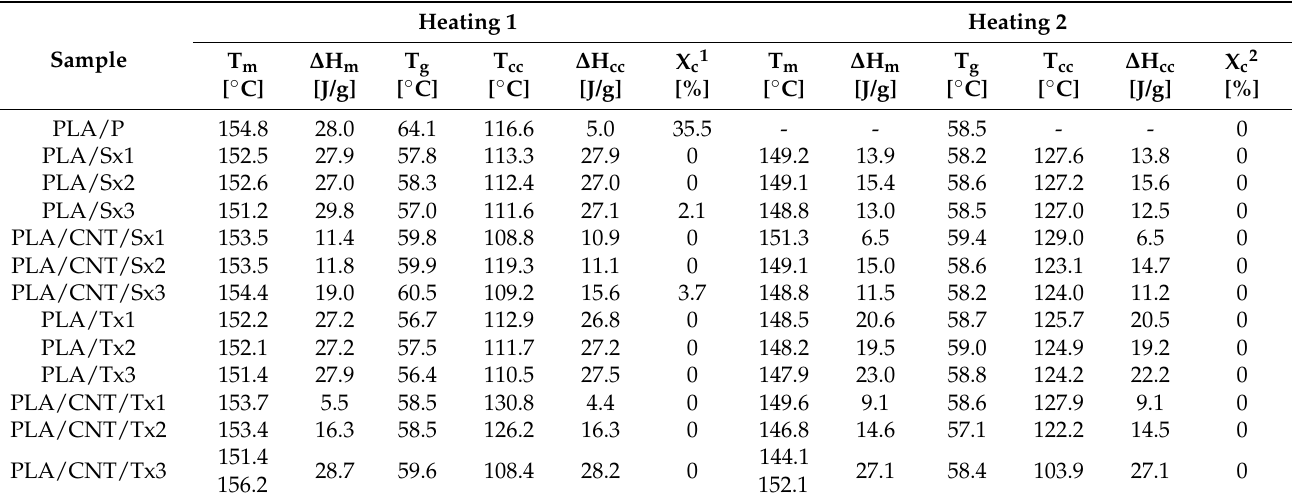
Table 7. Thermal data obtained by